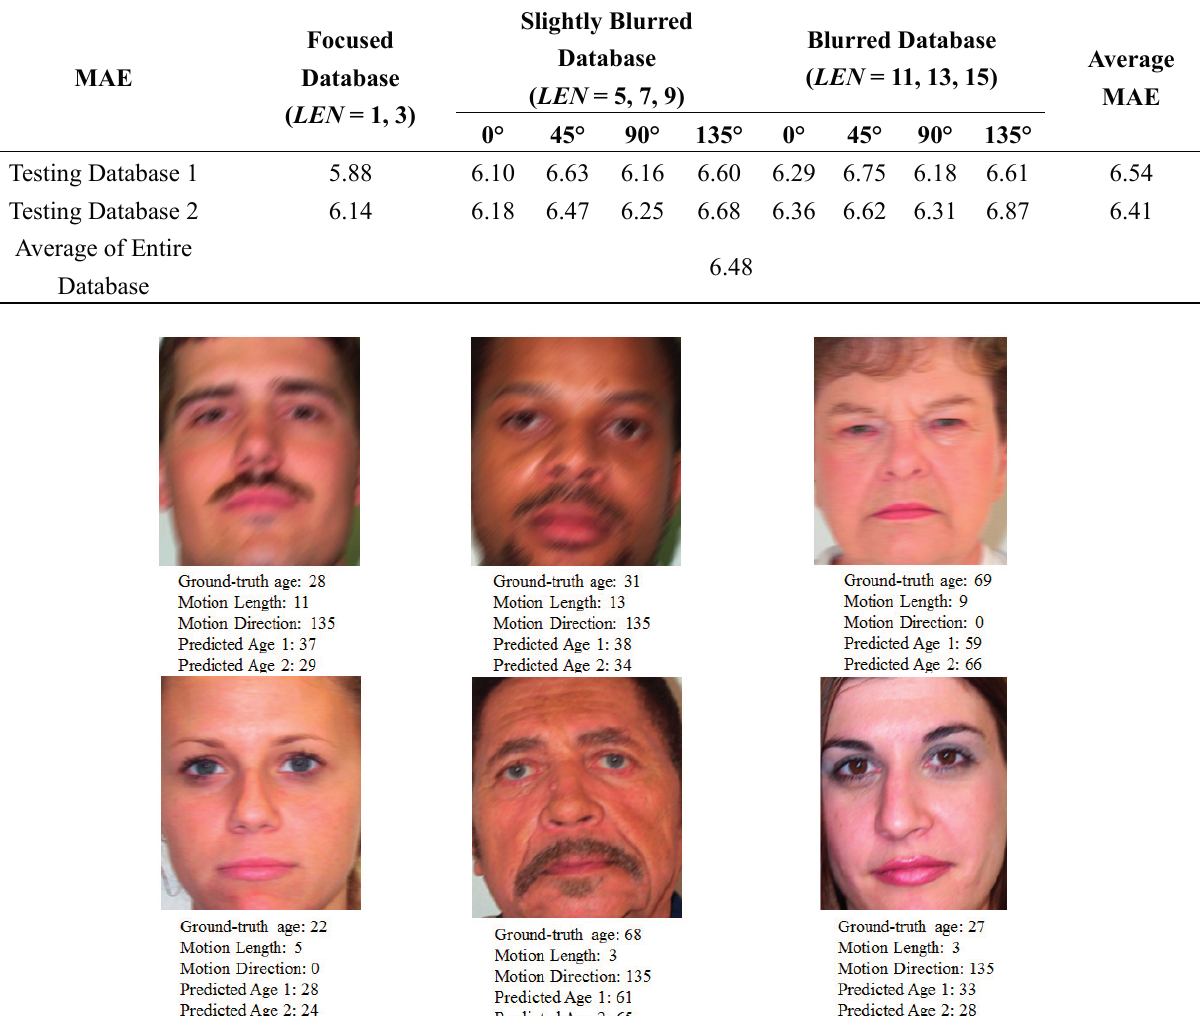
Table 8. Estimation performances of our age estimation method using motion blur databases.